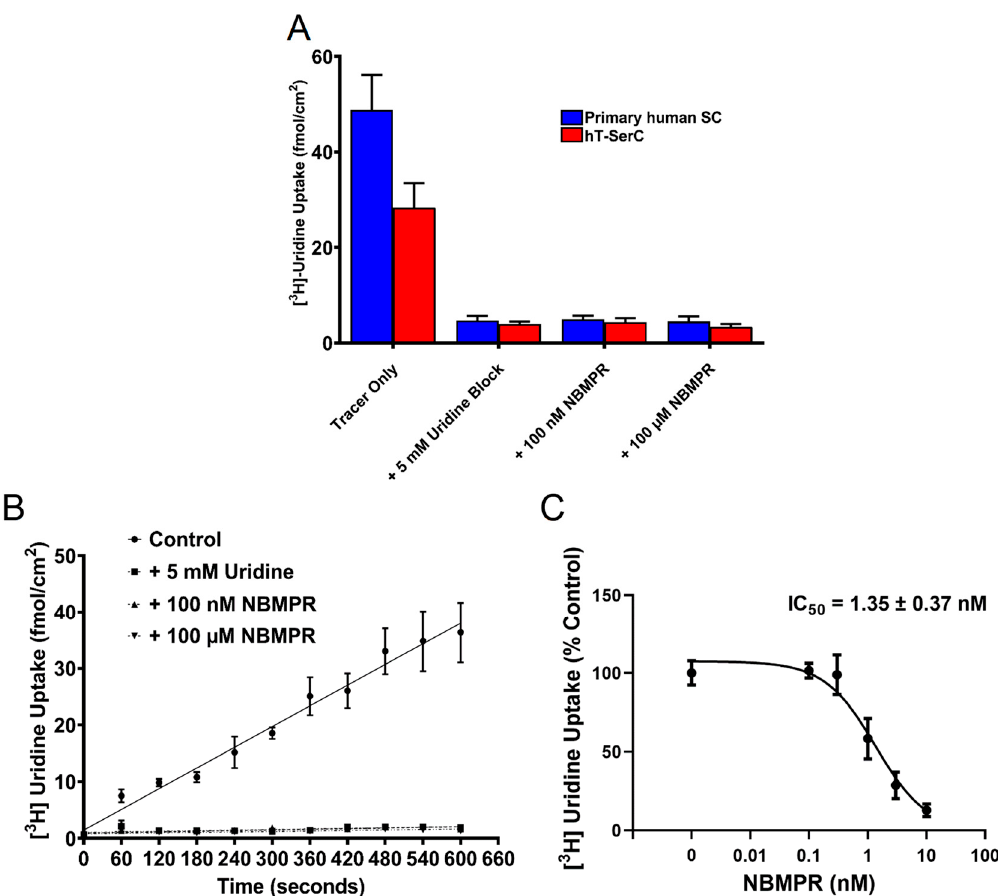
Figure 5. ( A ) Total [ 3 H] uridine accumulation into primary human SCs at passages 4–7 and post-passage 20 hT-SerCs after 10 min of uptake. Approximately 85–90% of uptake is blocked by 5 mM unlabeled uridine, 100 nM NBMPR, and 100 μ M NBMPR. Data are represented as the mean ± S.D. of five independent experiments. ( B ) Time-course experiment of [ 3 H] uridine uptake measured every minute for 10 min. [ 3 H] Uridine uptake is effectively linear over 10 min and approximately 85–90% of uptake is blocked by unlabeled uridine or NBMPR. The best-fit line represents a one-phase association. Data are represented as the mean ± S.E.M. of three independent experiments. ( C ) Inhibition of [ 3 H] uridine uptake by serially increasing concentrations of NBMPR from 0 to 10 nM. Transport was terminated after 10 min. The best-fit line was fitted using the monophasic inhibition model described by Equation (1). Data are represented as the mean ± S.E.M. of three independent experiments.